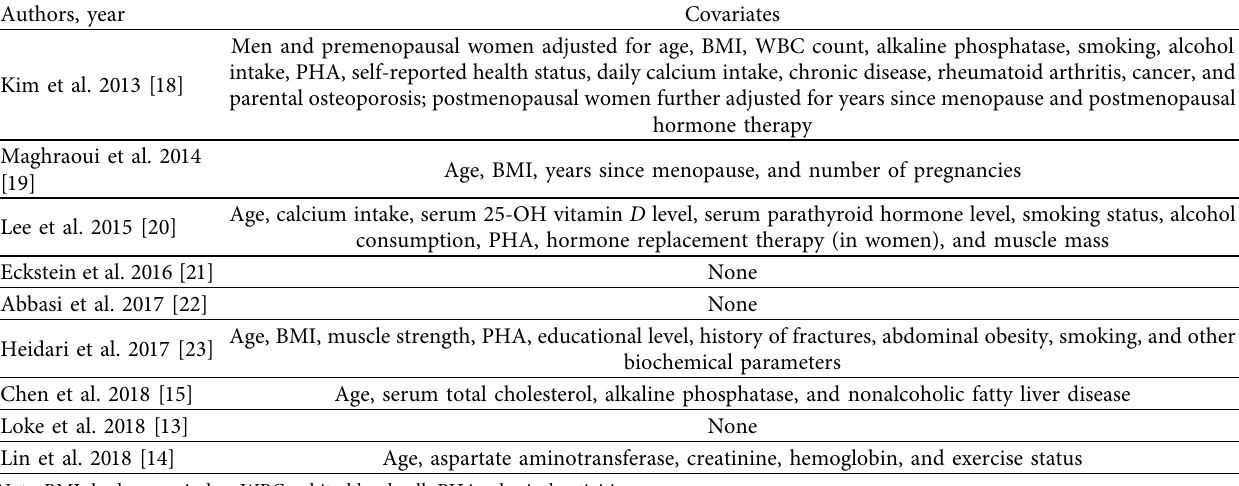
Table 2: Covariates adjusted for models of the associations between metabolic syndrome and osteoporosis.